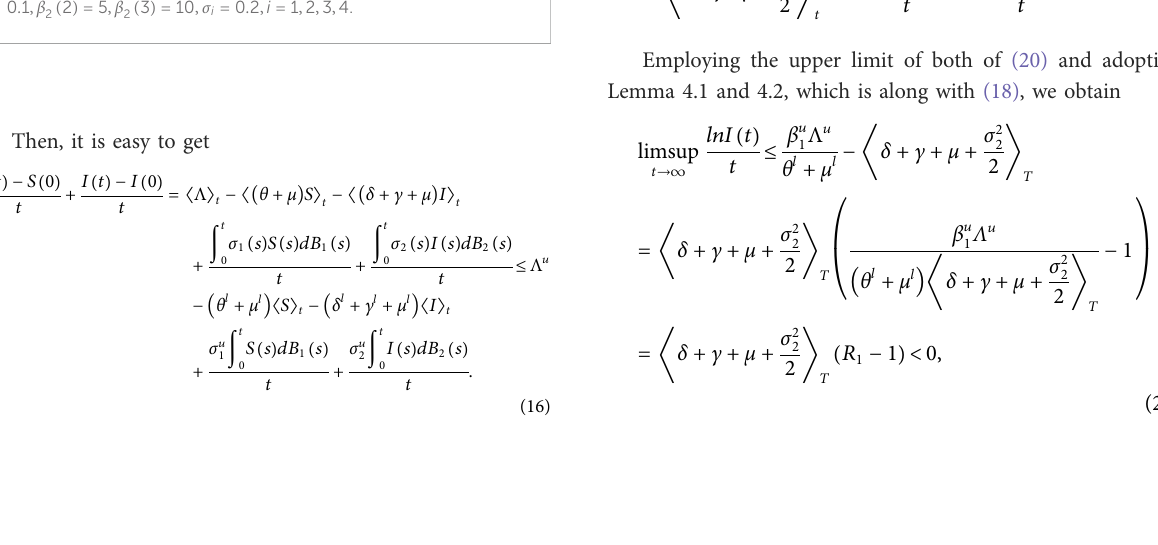
FIGURE 5 Path simulations of I(t) for the stochastic model with β 2 ( 1 ) (cid:2) 0 . 1 , β 2 ( 2 ) (cid:2) 5 , β 2 ( 3 ) (cid:2) 10 , σ i (cid:2) 0 . 2 , i (cid:2) 1 , 2 , 3 ,